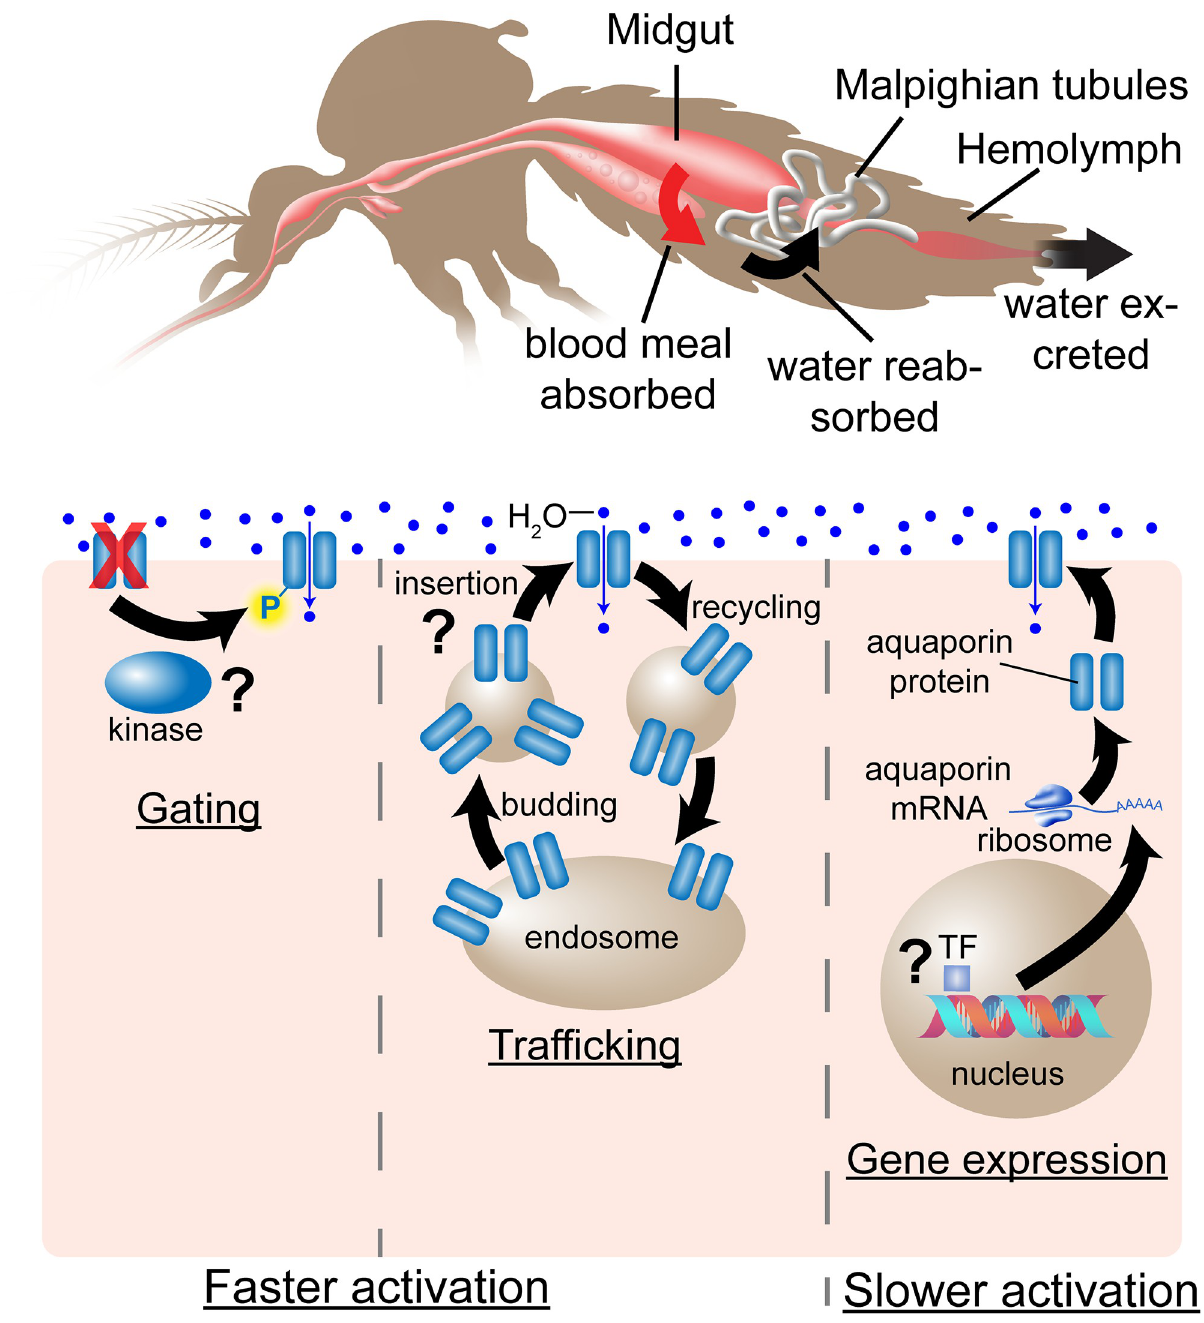
Fig 1. Alternative hypothetical mechanisms of transporter activation in MT cells, using AQPs as an example. Top: After blood feeding, female mosquitoes must rapidly eliminate large amounts of water and sodium from the ingested blood meal. Water, ions and nutrients from the blood meal are absorbed from the midgut into the hemolymph, and excess water and solutes are re-absorbed by the MTs and excreted in the process called diuresis. Bottom: Illustrated are three possible mechanisms of transporter activation in MT cells during diuresis. The quickest mechanism of activation is gating, or activation of transporters already inserted into the plasma membrane by post-translational modification such as phosphorylation or membrane voltage changes. A second rapid method of activation is trafficking of storage vesicles containing existing transporters to the plasma membrane. The slowest of the three mechanisms is de novo gene expression of transporter proteins in response to diuresis signaling.